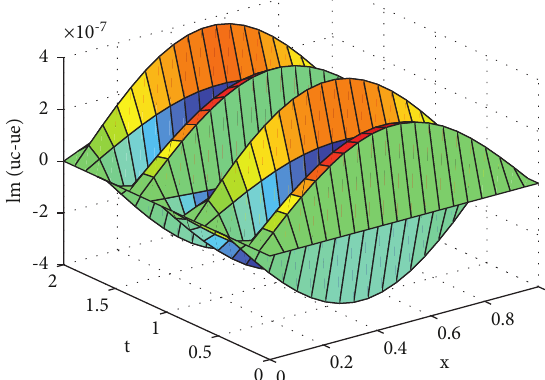
Figure 1: Error estimate of equidistant nodes with t � 2 , m � n � 19 , and d